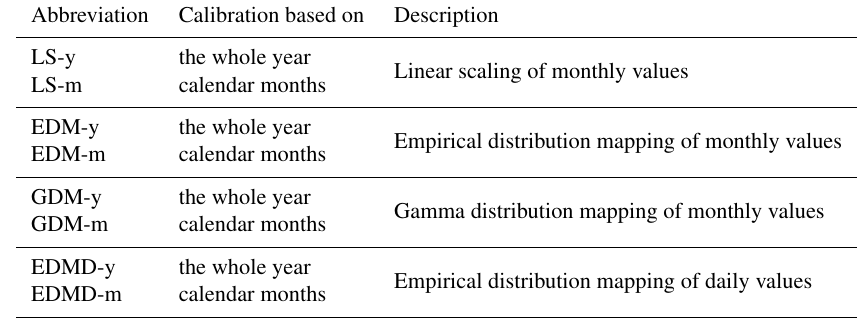
Table 2. Bias corrections applied to corresponding abbreviations, method used for calibration and